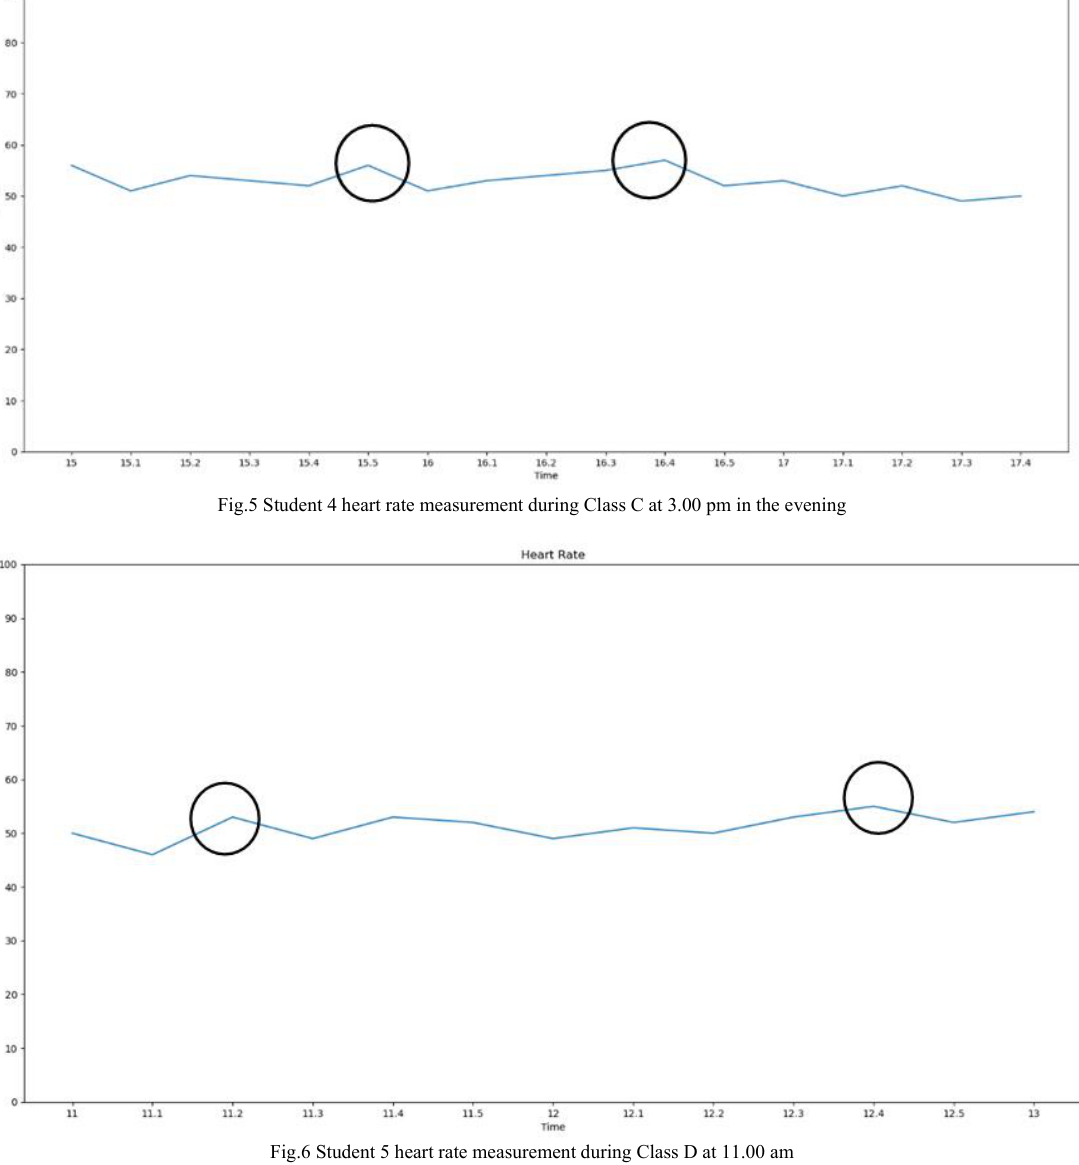
Fig.6 Student 5 heart rate measurement during Class D at 11.00